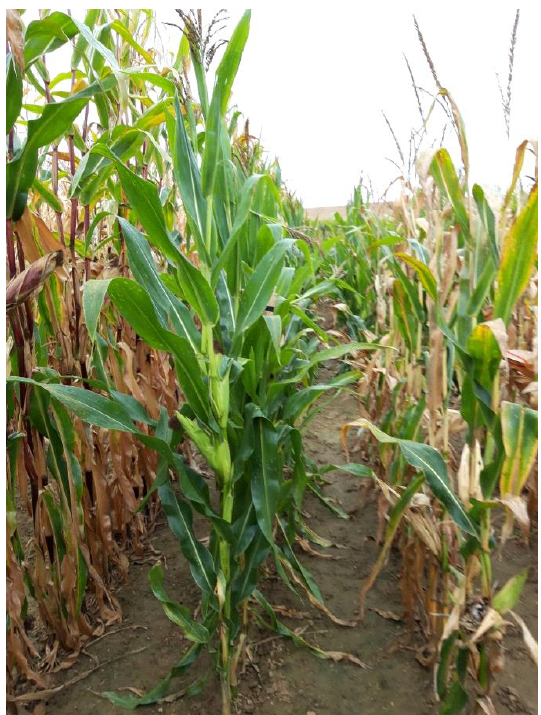
Figure 2. Comparison of different delay of senescence phenotypes of maize planted in a nursery (Baden-Württemberg, Germany). Photo courtesy of Hans Seifert.